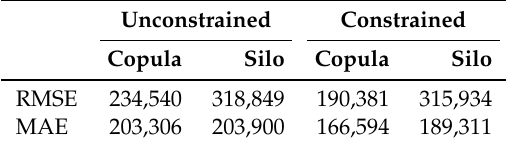
Table 7. Summary of validation performance measures of the fitted